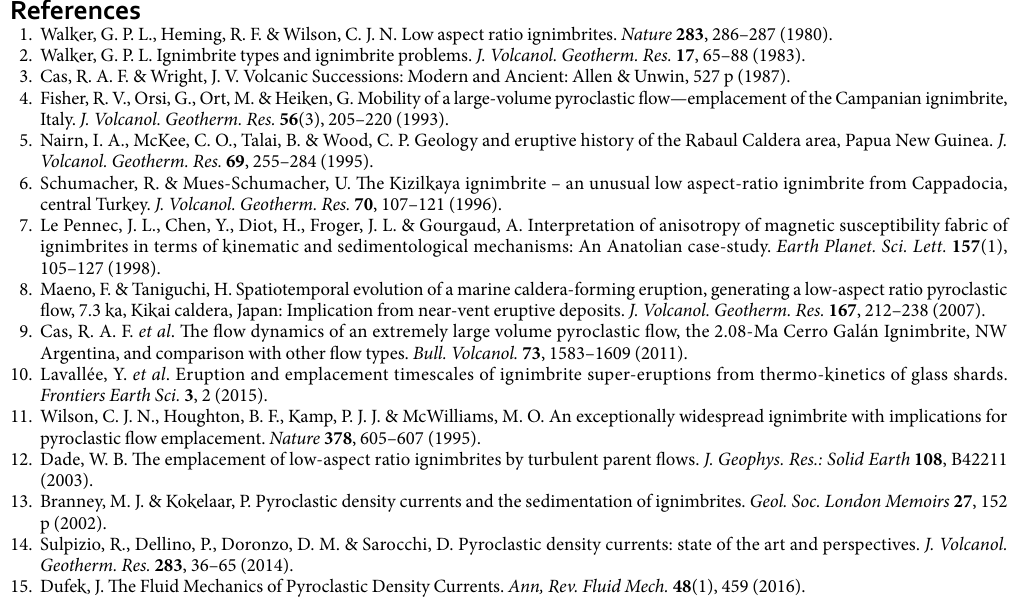
use of field measurements like lithofacies variations and thicknesses. Figure 4 summarizes the main PDC pro- cesses that can be inferred from the spatial gradient of the topological aspect ratio (dAR t /dx): (i) Mild positive AR t gradients and low AR t values describe forced PDCs, related to sustained flow pressure at high mass discharge rates (e.g. in caldera-forming eruptions; in forcing topography, such as steep downslopes or longitudinal val- leys); the forced region of the PDC includes both the transportational and depositional systems, so that the flow boundary layer (f.b.l.) is well inside this region (Fig. 4a) [ref. 13]; deposits are aggraded to tabular geometries (e.g. constant thickness or increasing with distance), and are dominantly massive-and-chaotic, although inter- nal organization and cross-stratification are possible where velocity flux is high; (ii) Flat AR t gradients describe zones where forcing and inertia are balanced, such as in medial-distal areas where PDCs spread on flat and open topographies, progressively dropping flow pressure and mass via deposition; the forced region thins and the f.b.l. is closer to the inertial region of the flow; deposits have mildly decreasing thicknesses with distance, and can be massive-and-chaotic to internally organized; (iii) Negative AR t gradients describe zones where the PDC becomes dominantly inertial, such as in pyroclastic surges, above topographic highs, or where the flow pressure drops via rapid sedimentation, such as beyond topographic obstacles (Fig. 4b); the inertial region, where turbulence dom- inates, is therein very close to directly in contact with the f.b.l.; deposits have strong decreasing thicknesses with distance, and are internally organized to structured. A major outcome of our analysis is that the so called LARI encompass a wide range of flow behaviors 1, 4, 6, 8, 9, 11, 30 and this explains why previous authors had not found a simple correlation between regional AR and volume 31 .